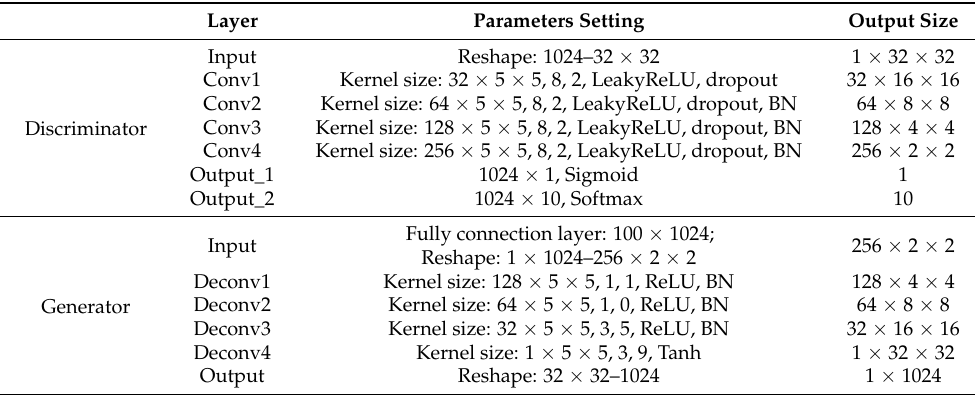
Table 1. The structure of the discriminator and generator. Layer Parameters Setting Output Size